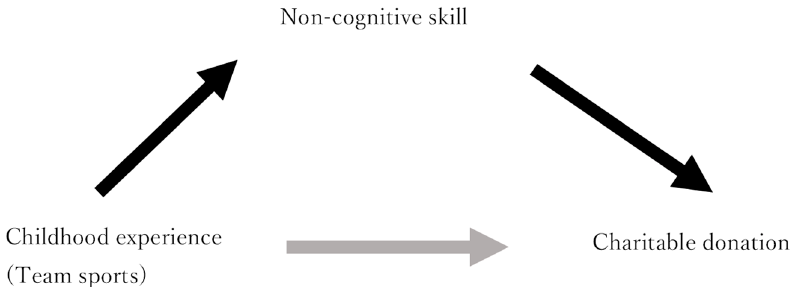
Figure 1. Mechanism by which childhood experiences cause persons to donate via the formation of non-cognitive skills. Notes: The shaded arrow exhibiting the direct effect, which is generally weak; childhood experiences are therefore appropriate for IVs.